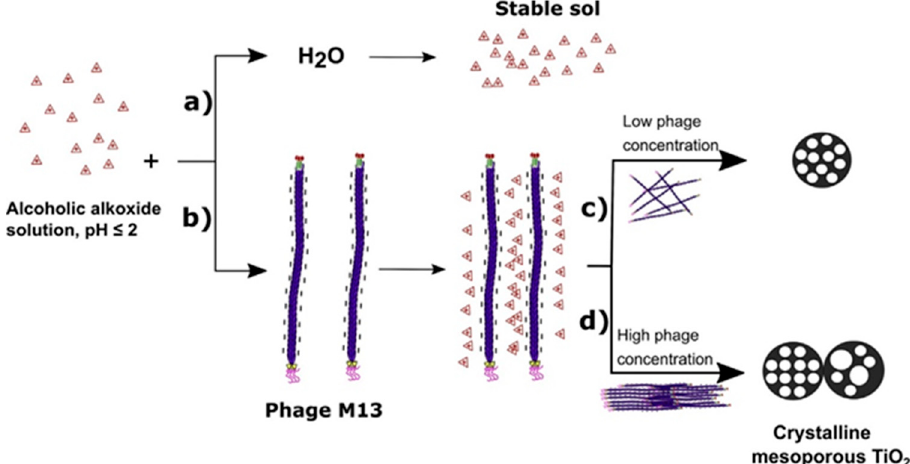
Figure 2. Proposed mechanism of mesoporous TiO 2 synthesis: consist in the preparation of a titanum alkoxide (titanium(tetra)isopropoxide) solution at pH ≤ 2. A vary stable sol is obtained with acid aqueous solution (pH 1–2) ( a ); the sol-gel reaction is performed with Phage M13 and a well-established structure is obtained ( b ). A local order of pores and macropores can be obtained at high phage concentration ( d ), while disordered pores with a narrow pore size distribution at a low concentration ( c ). Reproduced with permission from [36]. Copyright © 2019 4541961016973.